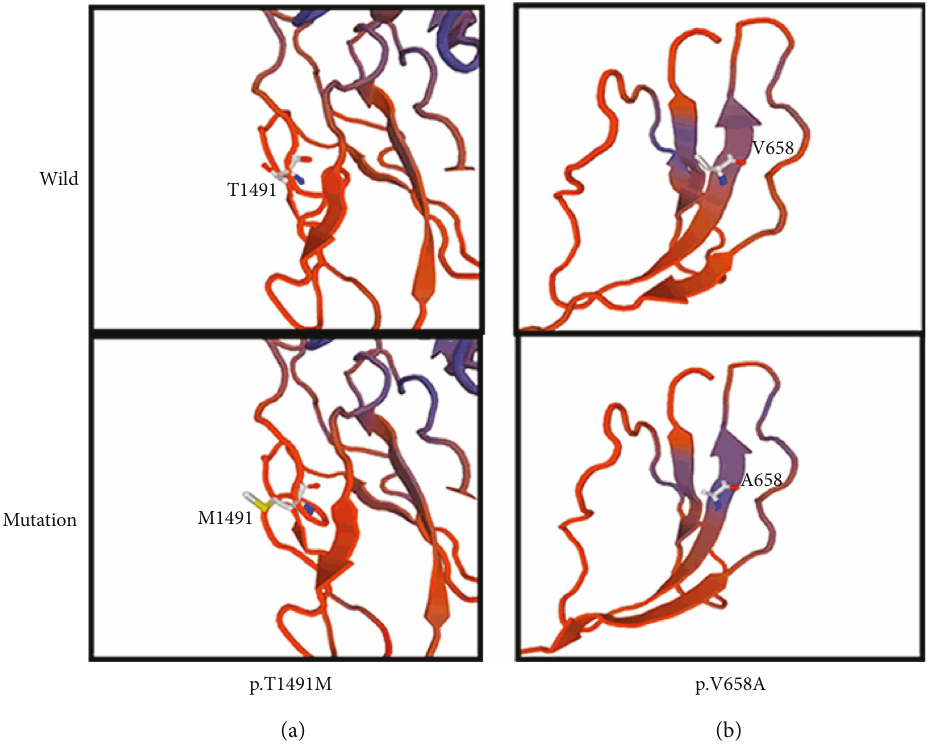
Figure 3: Protein molecular models of wild types and PTPRQ mutations. (a) The mutation protein M1491 has a di ff erent side chain to the wild-type protein T1491. (b) The wild-type protein has a longer side chain than the mutation protein